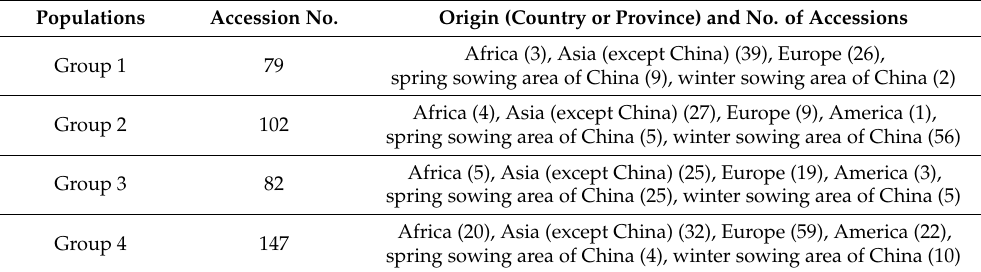
Table 3. The compositions of group inferred by cluster analysis of 410 faba bean accessions based on the NJ method.